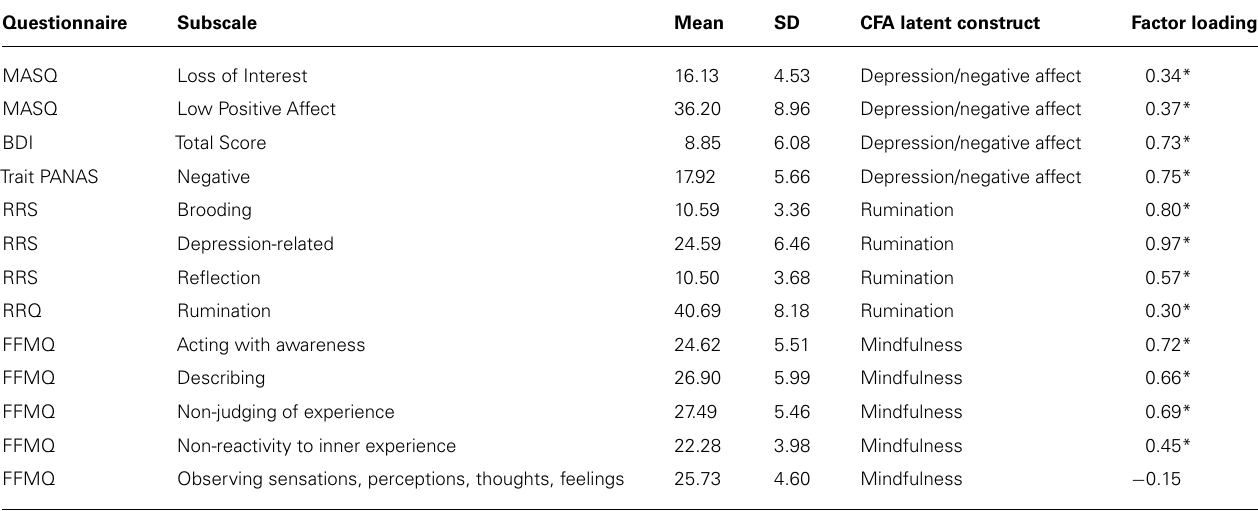
Table 2 | Constructs related to emotional health and